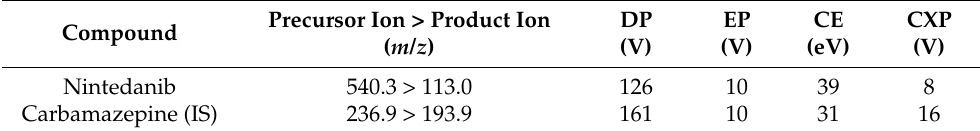
Table 1. MRM condition for nintedanib and